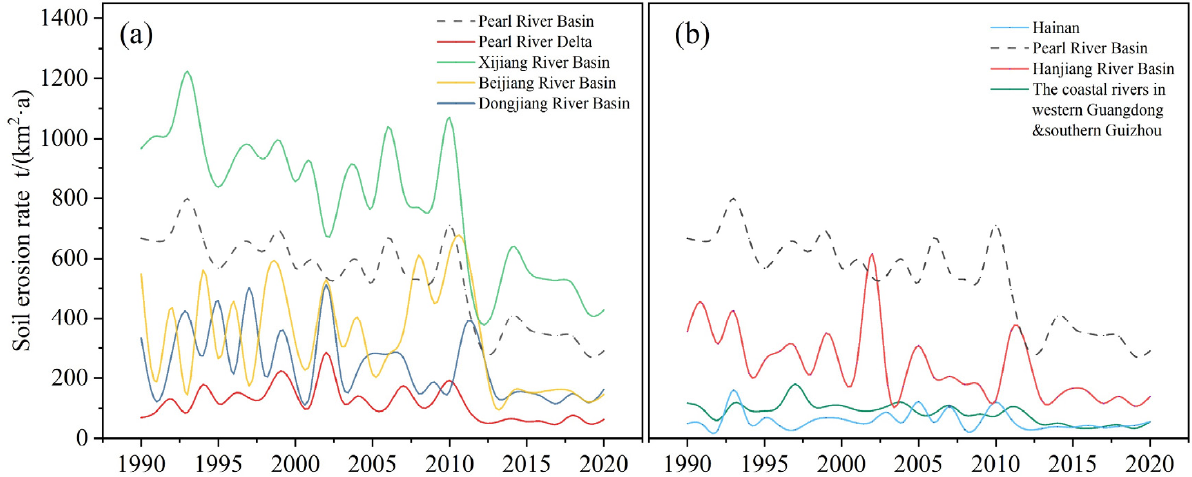
Figure 5. Soil erosion rates in the GPRB and its sub-basins in the past 30 years. Most sub-basins experienced a significant decreasing trend, excluding the PRD. ( a ) soil erosion rate in PRD, PRB, XRB, BRB, DRB; ( b ) soil erosion rate in HI, PRB, HRB, CRSG&WG.